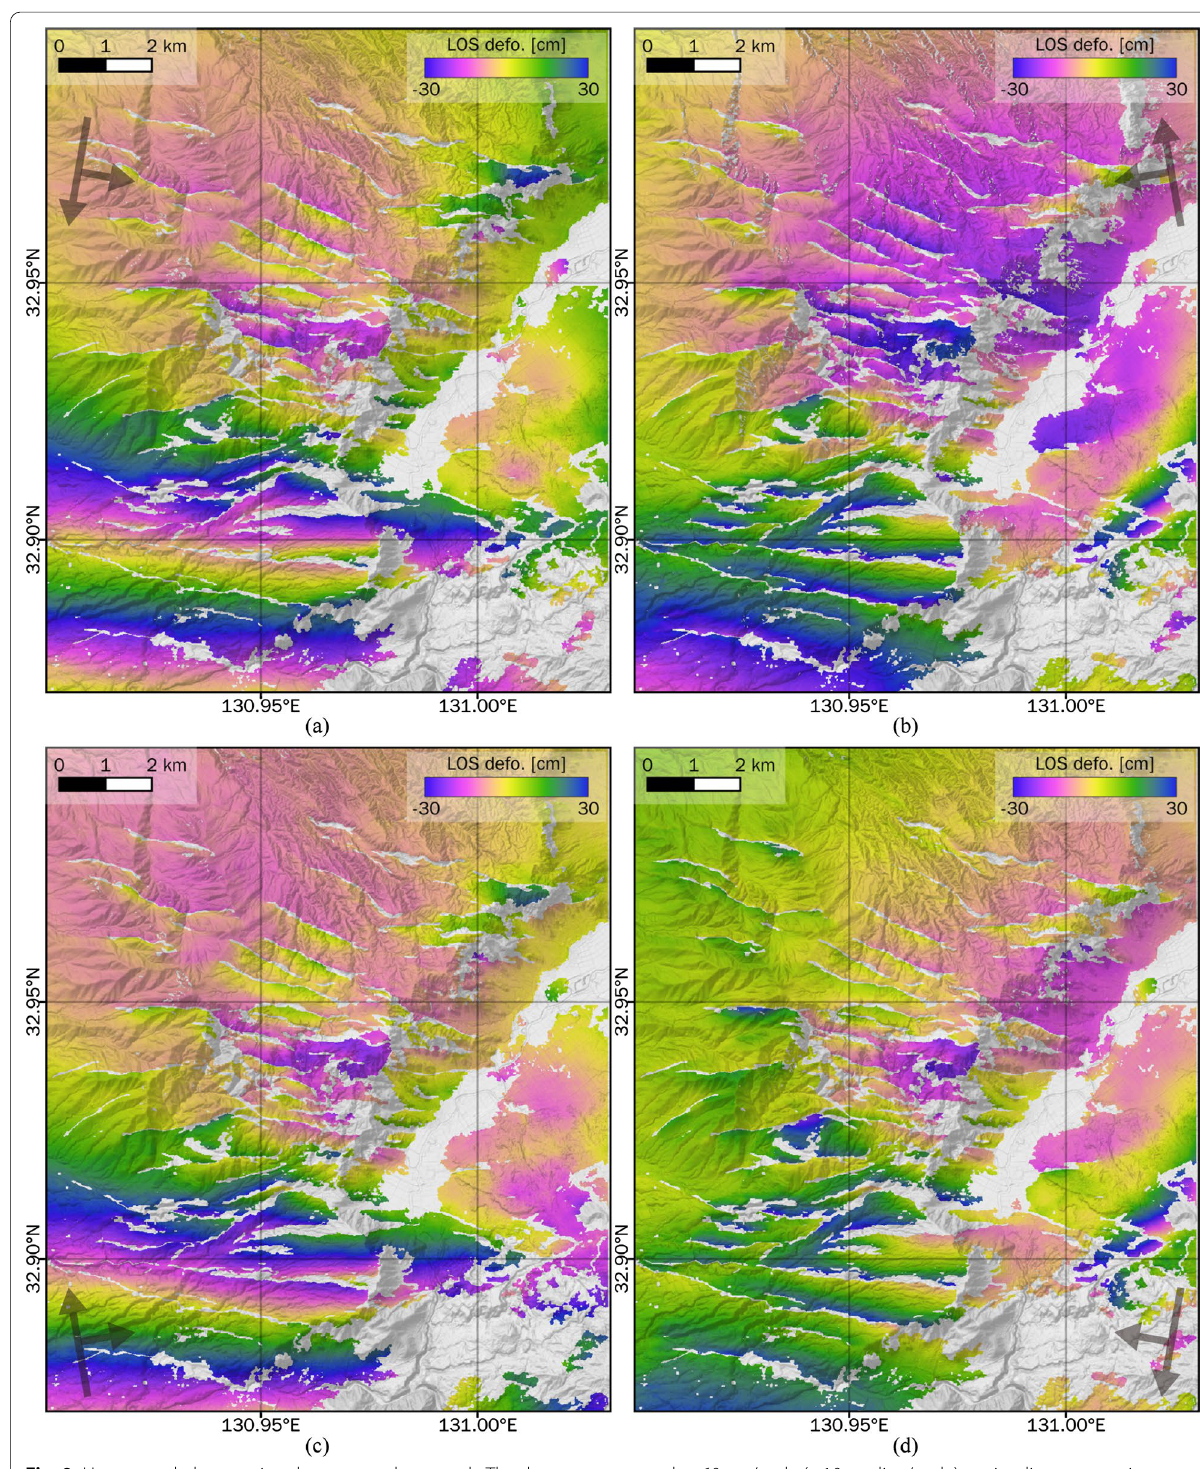
Fig. 9 Unwrapped phases using the proposed approach. The data are rewrapped to 60 cm/cycle (~ 10 π radian/cycle) to visualize unwrapping errors. a Descending left-looking. b Ascending left-looking. c Ascending right-looking. d Descending